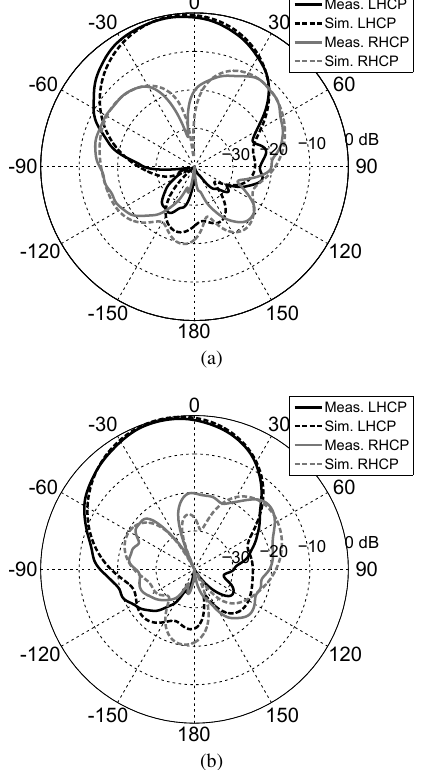
FIGURE 17. Radiation patterns for the CP Half E-shaped patch antenna prototype at 2.45 GHz. (a) ϕ = 0 ◦ (XZ plane) (b) ϕ = 90 ◦ (YZ plane). Adapted from